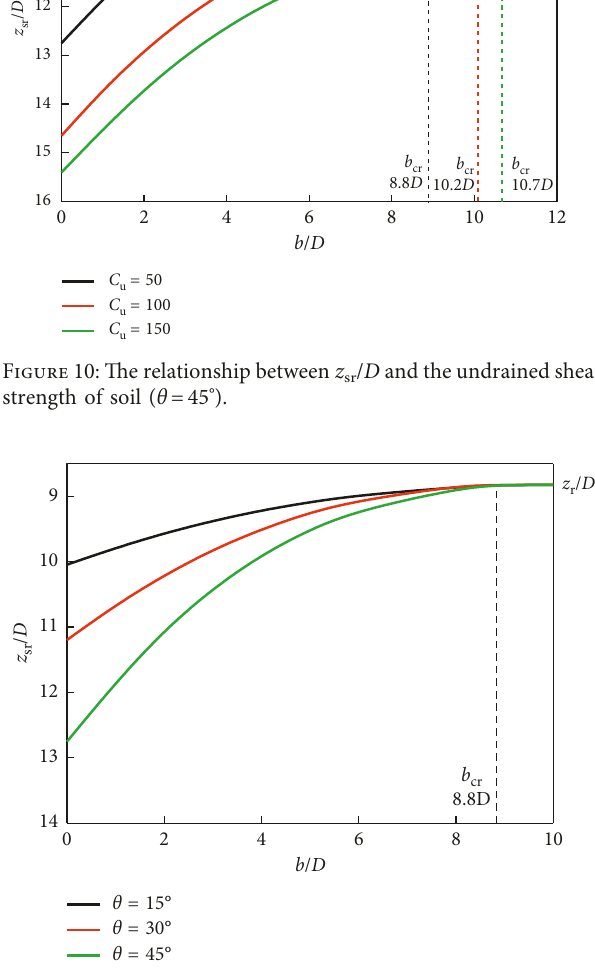
sr / D and the angle of slope θ